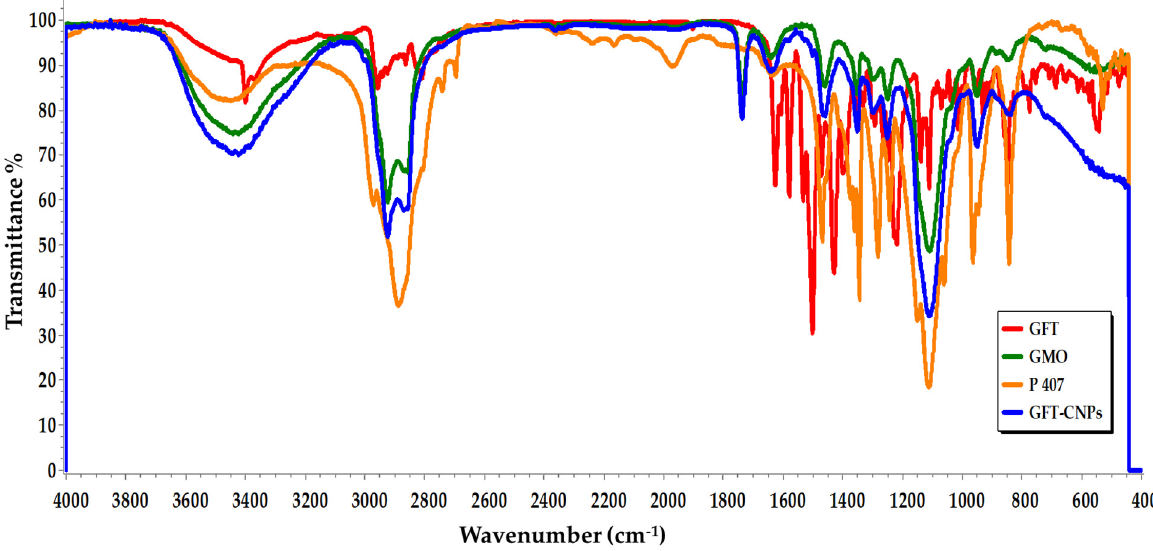
Figure 3. FTIR spectra of pure GFT, GMO, P407, and optimized GFT-CNP formula